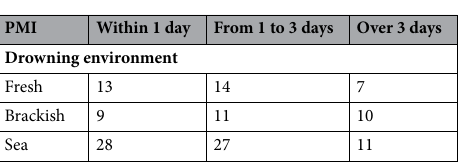
Table 1. The case number classified to PMI and drowning